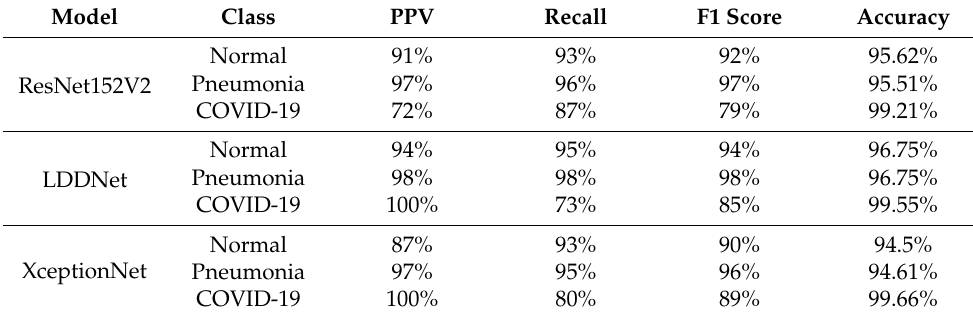
Table 9. Comparison of different DL models for the Nadam